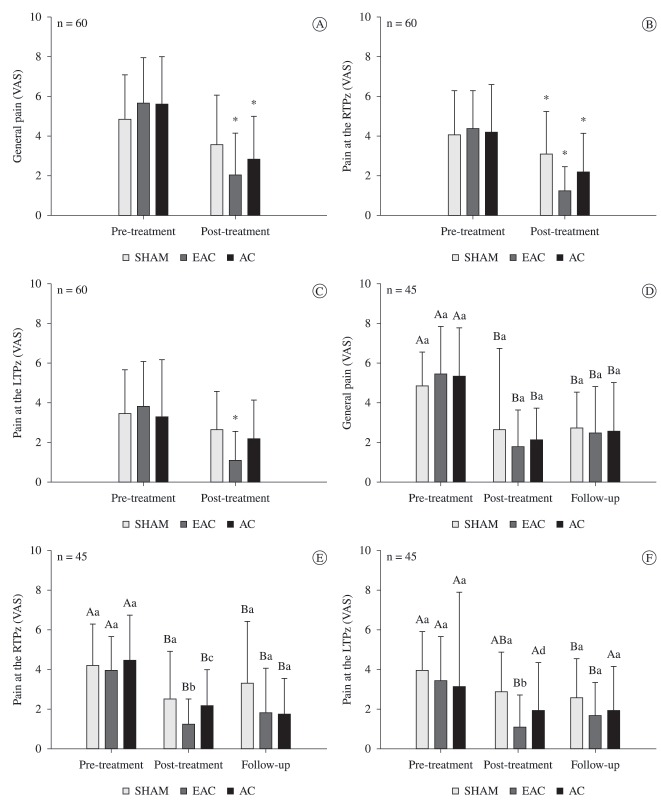
Means and standard deviations for general pain (A), pain at the right
upper trapezius (B) and at the left upper trapezius (C) in pre- and
post-treatment and including the follow-up evaluation (D, E, F). Uppercase
letters above the standard deviation bars refer to intragroup comparisons:
A?B (P<0.05); lowercase letters refer to intergroup comparisons: c:
AC=EAC and AC=SHAM; d: SHAM=AC and AC?EAC; a?b*(P<0.05).